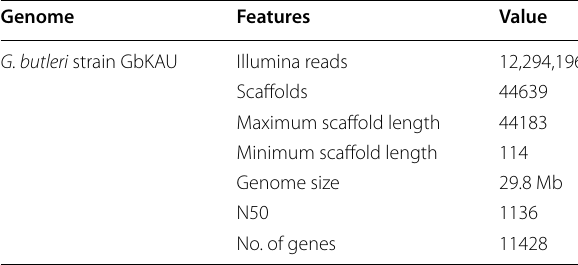
Table 3 Genome features of the fungus G. butleri